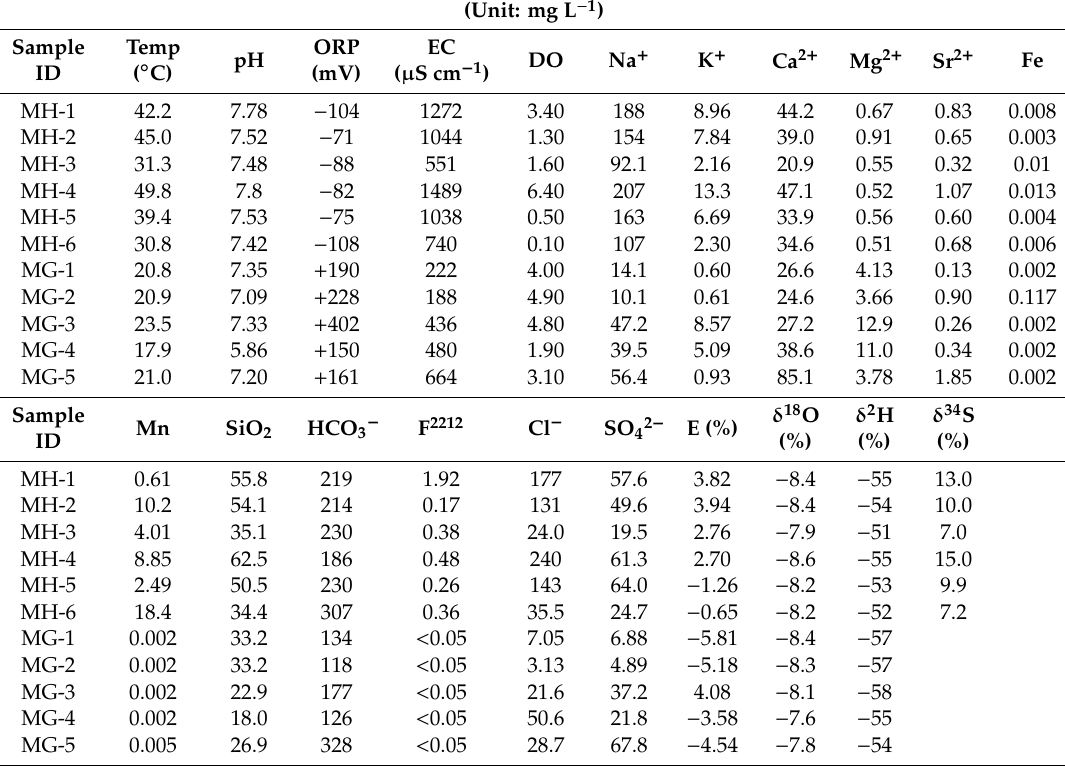
Table 1. Geochemical and isotopic compositions of thermal water and groundwater samples that were collected in the Magumsan